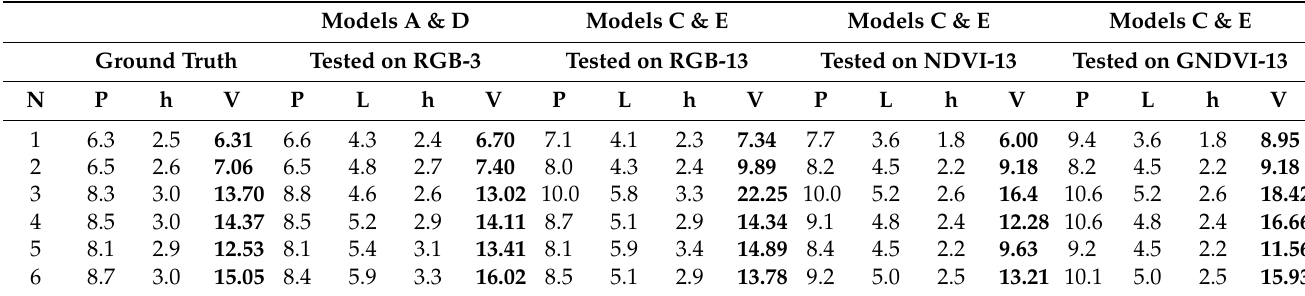
Table 5. The averaged characteristics by best trained models for 6 test olive trees, where P is the perimeter of the tree crown polygon used as the circumference of the cylinder base, h is the tree height derived from the tree shadow, L is the tree shadow length, V is the approximate volume of the tree canopy. P , L , and h are expressed in m; V is in m 3 . Models A (tree crown) and D (tree shadows) were trained and tested on RGB 3 cm/pixel images. Models C (tree crown) and E (tree shadow) were trained on a data fusion of the RGB, NDVI, and GNDVI altogether at 13 cm/pixel images but tested separately on each subset of data at 13